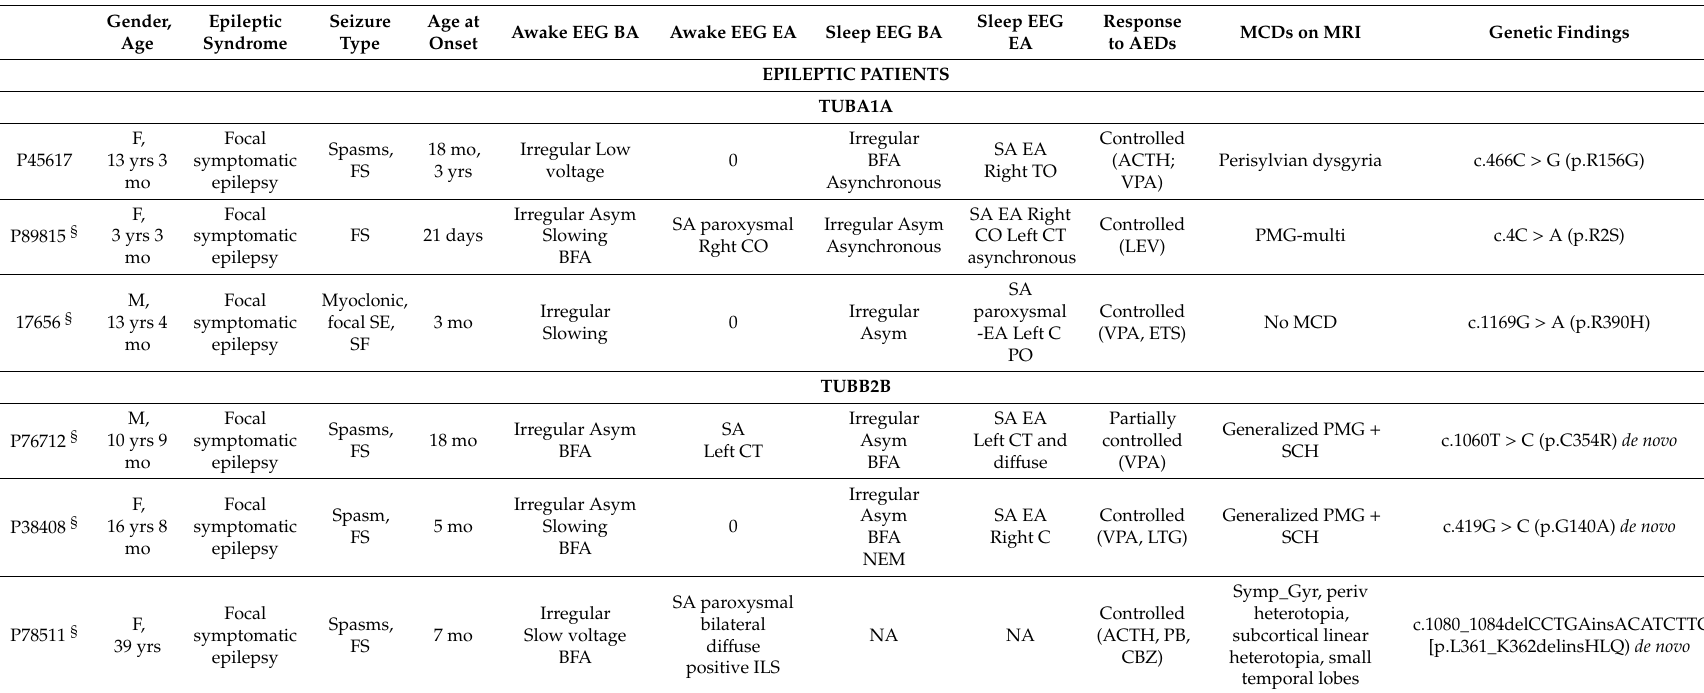
Table 1. Electrophysiological findings of our